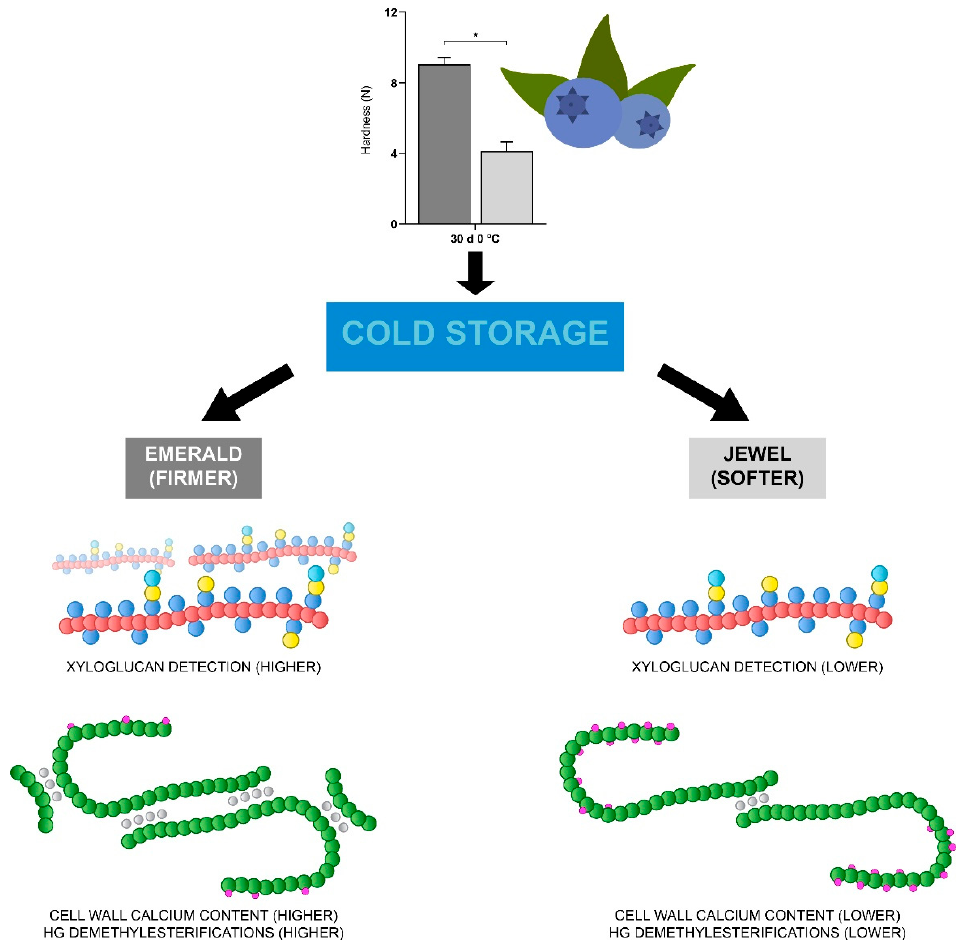
Figure 6. Schematic representation of main results showing xyloglucan detection (red backbone) and cell wall-associated calcium and methylesterification status of GalA (green backbone) for Emerald and Jewel cultivars ( p < 0.05).